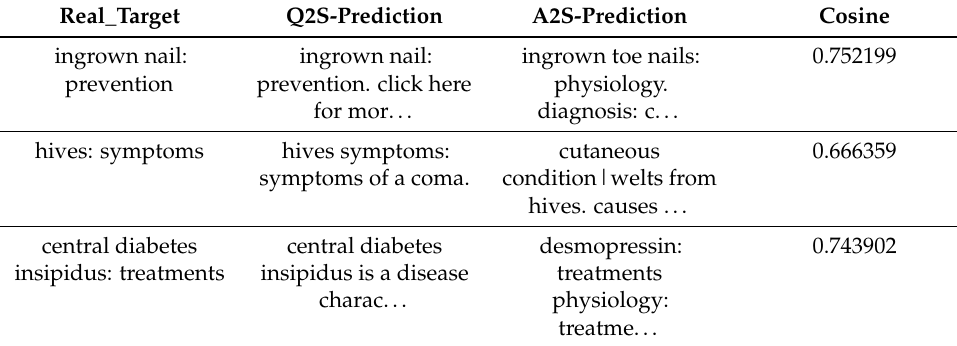
Table 11. Prediction results of our system: full